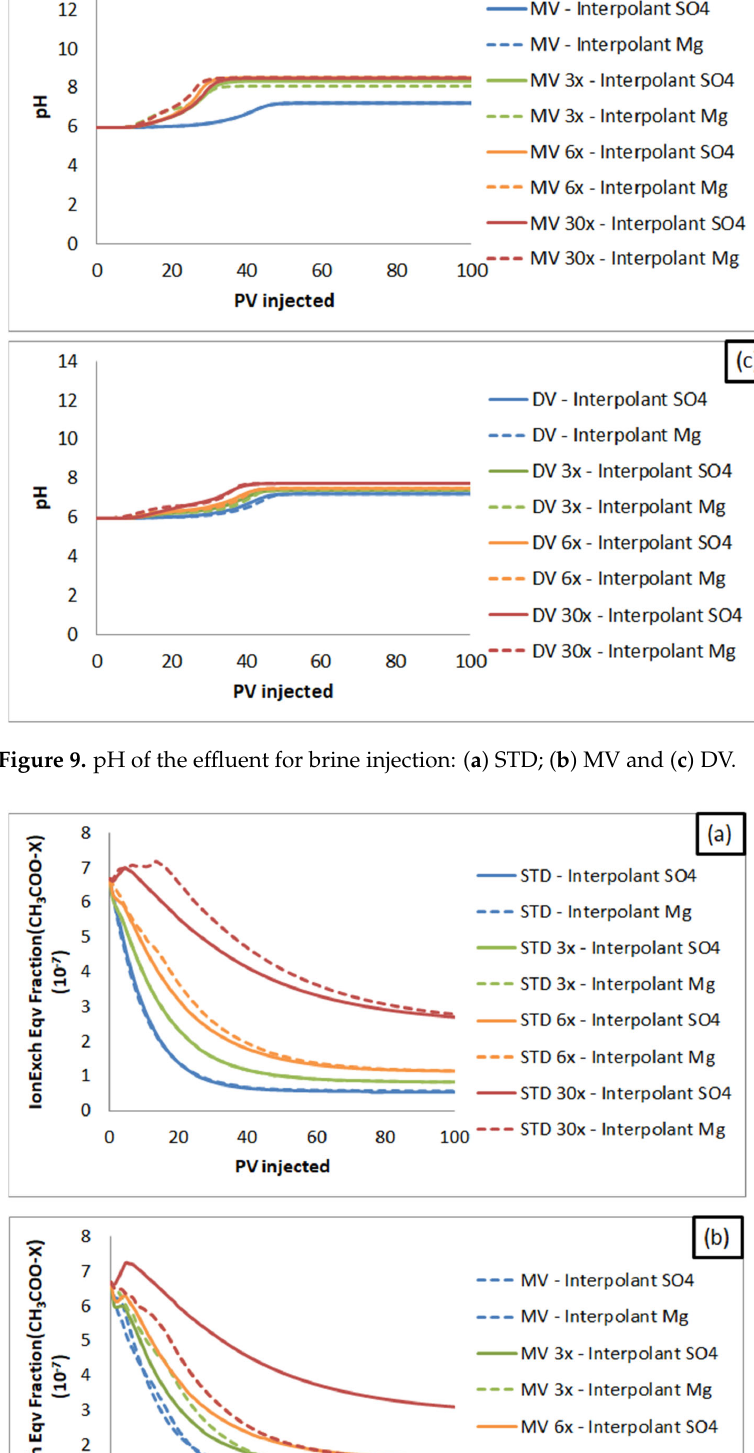
Figure 10. Ion Exchange Equivalent Fraction (CH 3 COO ‐ X) variation in the grid block {1,1,1} for brine injection: ( a ) STD; ( b ) MV and ( c ) DV.